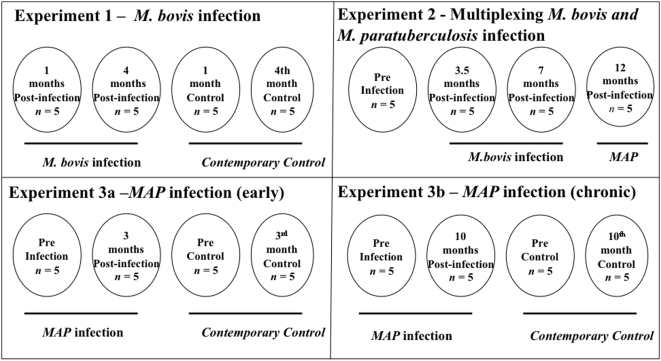
Experimental design used for four iTRAQ analyses with combinations of sera from M. bovis and/or M. paratuberculosis infections in calves.Shown in each quadrant is the experimental design for either M. bovis or M. paratuberculosis infections. Pre- and post-infection time points at which sera were collected and applied in iTRAQ analyses are identified. Numbers in brackets represent the numbers of sera from each group that was pooled for analysis. Experimental design also included contemporary controls.